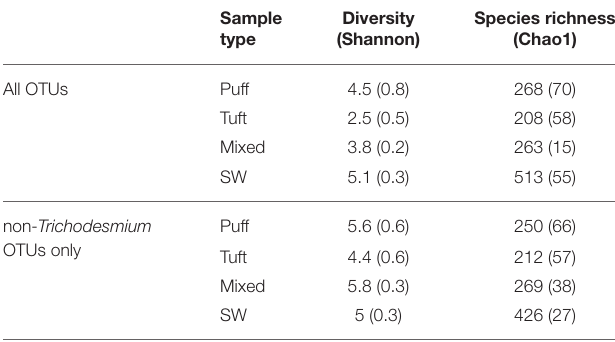
TABLE 3 | Diversity and species richness